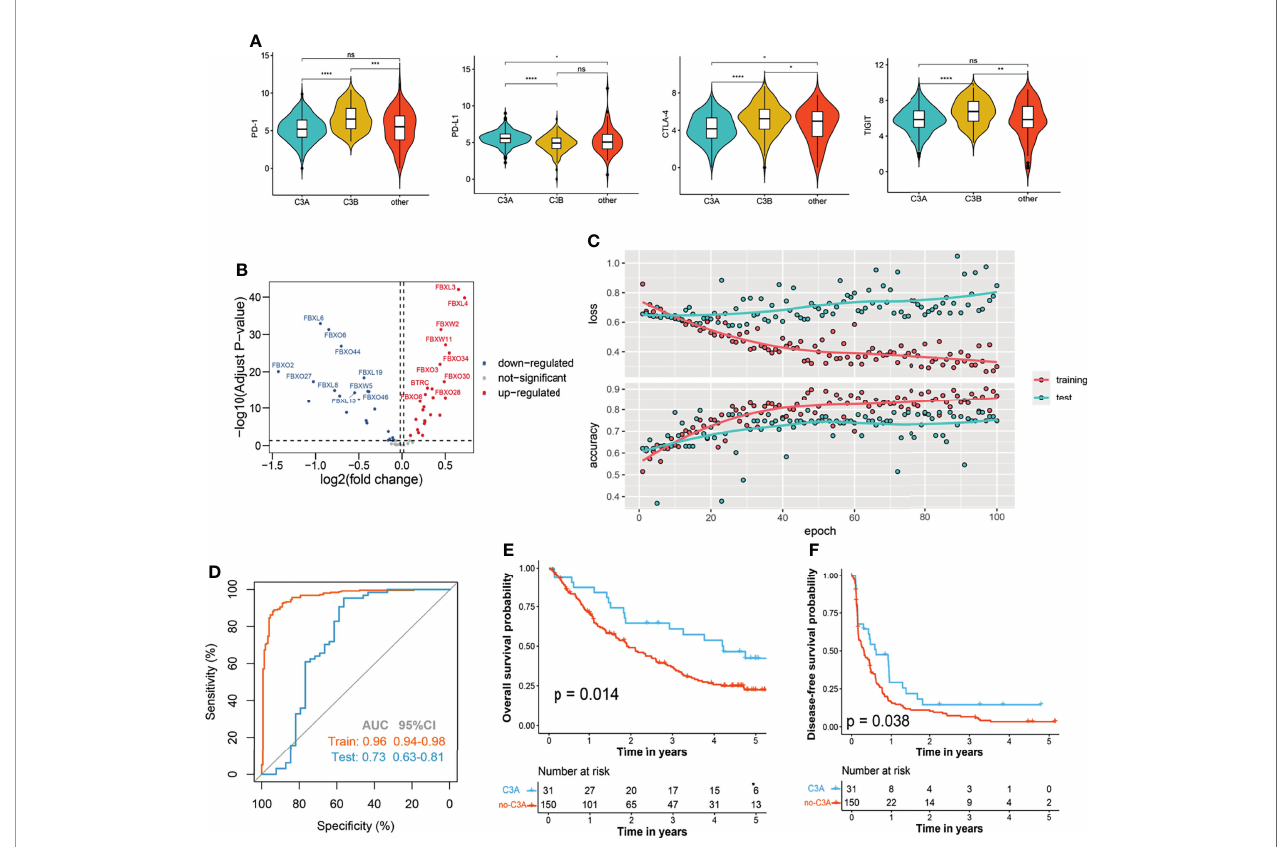
FIGURE 7 | Increased response to anti-PD-1 immunotherapy exists in C3A cluster. (A) Comparison of the main immune checkpoints among different clusters. (B) Volcano plot shows the differentially expressed f-box family genes. (C) The learning curves of the deep learning-based model predicting the cluster of C3A. (D) Receiver operating characteristic curves for the prediction of C3A cluster in the training and test set. (E) Kaplan – Meier survival analysis of overall survival between patients treated with ICIs in the C3A cluster and others. (F) Kaplan – Meier survival analysis of disease-free survival between patients treated with ICIs in the C3A cluster and others. ICIs, immune checkpoint inhibitors. *p < 0.05; **p < 0.01; ***p < 0.001; ****p < 0.0001; ns, non-signi fi